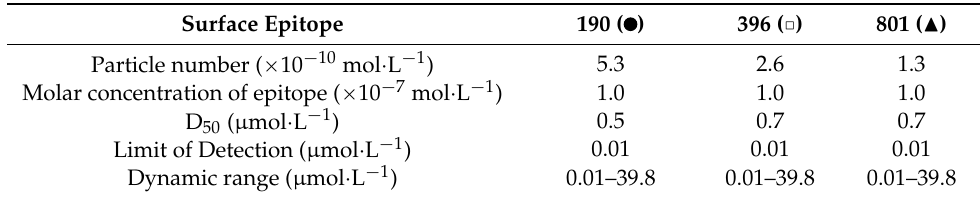
Table 3. Displacement assay parameters derived from Figure